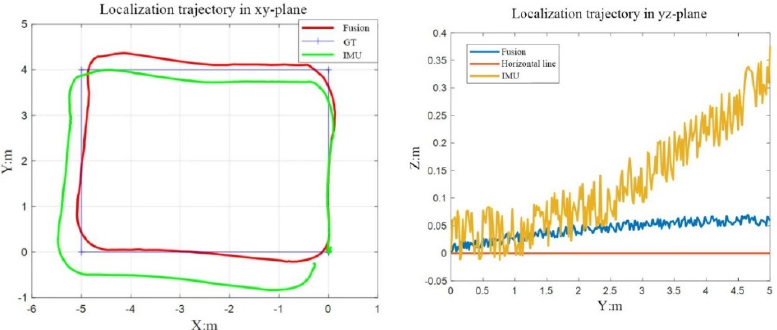
Figure 10. The comparison of localization accuracy between two algorithms in XOY and YOZ planes.